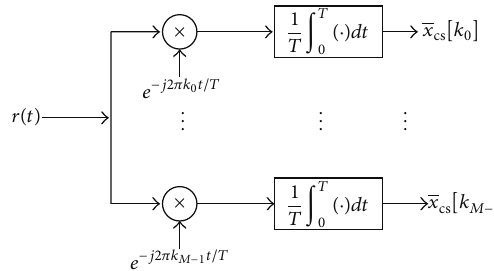
Figure 1: Multichannel direct sampling of the Fourier series coeffi- cients, from